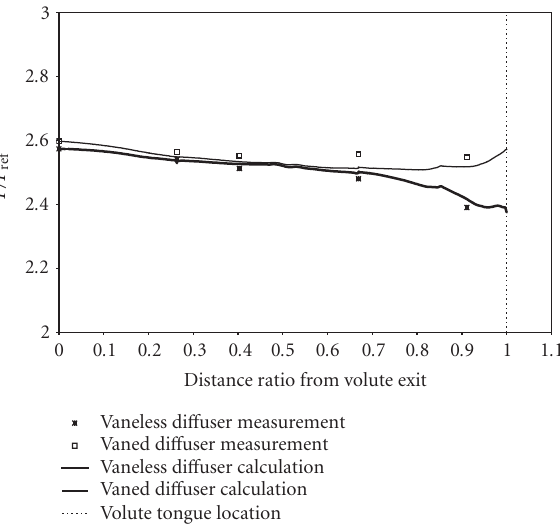
Figure 7: Static pressure on the volute wall for the vaneless and vaned di ff users.